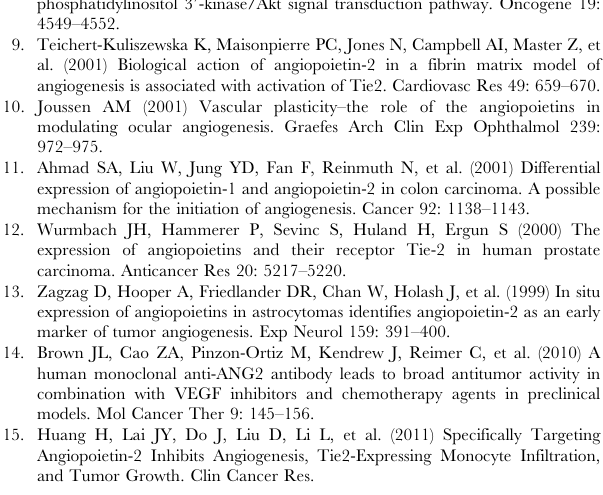
LC08 bind with high affinity to cynomolgus (EC50 of 40.6 pM for LC06 and 64.2 pM for LC08) and murine Ang-2 (EC50 of 38.8 pM for LC06 and 88.6 pM for LC08). The SPR data confirm similar single digit nM affinity of all tested antibodies targeting human Ang-2. The ELISA results were calculated from two independent experiments (n value = 3). Table S2 Binding of LC06 and LC08 in Tie2 ELISA and FACS analysis. Blocking of human Ang-1/Ang-2 to human Tie2 interaction was shown by receptor interaction ELISA. LC06 was found to bind Ang-2 with an IC50 value of 79 pM whereas the ability of the antibody to bind Ang-1 was determined with an IC50 above 50000 pM (detection limit). LC08 was found to bind Ang-2 with an IC50 value of 104 pM whereas the ability of the antibody to bind Ang-1 was determined with an IC50 of 4368 pM. The ELISA results were calculated from two independent experiments (n value =3). FACS analysis confirmed the comparable binding of LC06 (1 nM) and LC08 (1.3 nM) to Ang-2. The FACS results were confirmed in a second independent